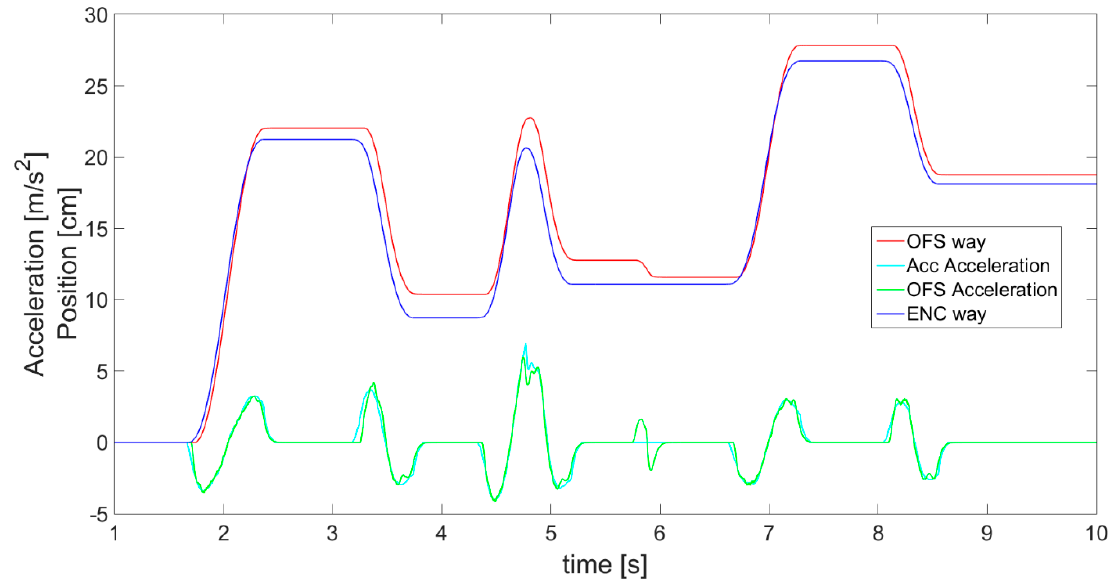
Figure 16. Data for accelerometer and OFS estimated displacements compared with encoder values.